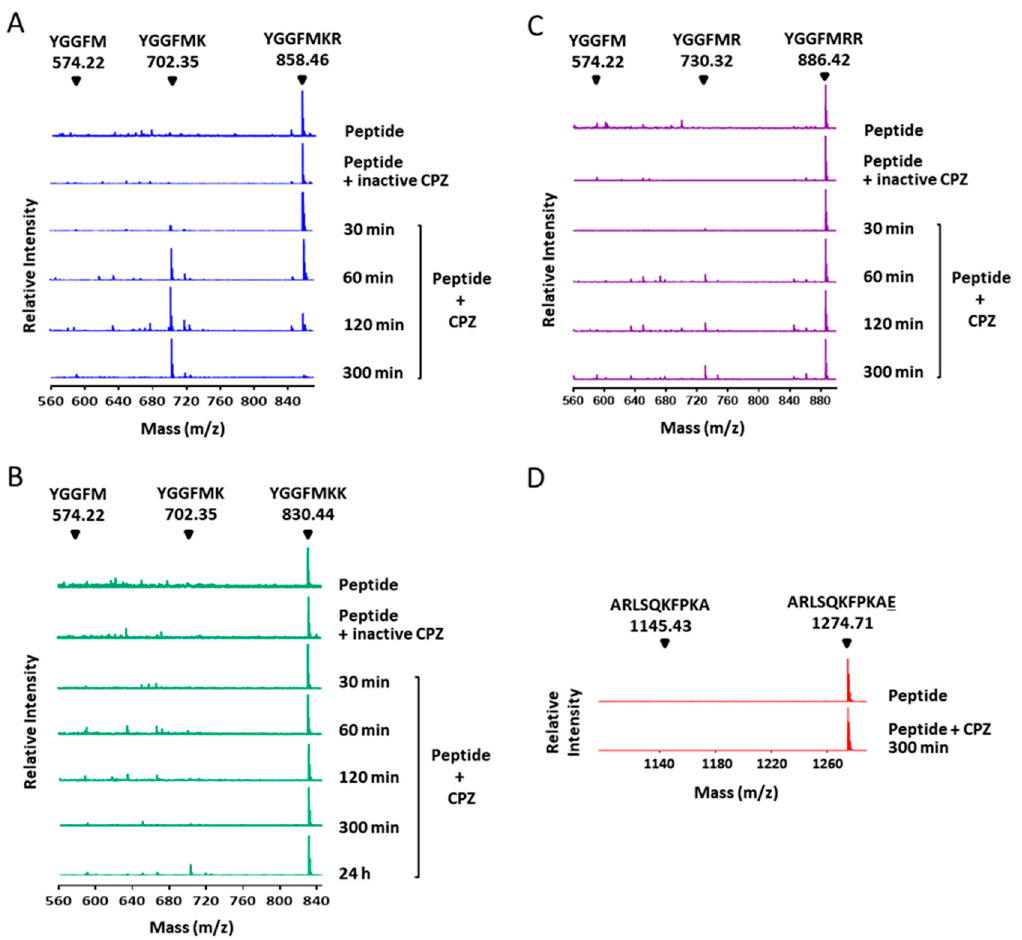
Figure 7. Substrate specificity of CPZ against Met-enkephalin-derived peptides. MALDI-TOF MS spectra of Met-enkephalin-derived peptides ( A ) YGGFMKR, ( B ) YGGFMKK, and ( C ) YGGFMRR treated with 100 nM CPZ at 37 °C with different incubation times. The peaks with a mass of 858.46 Da, 830.44 Da and 886.42 Da correspond to the peptides YGGFMKR (theoretical monoisotopic MH+ mass = 858.41 Da), YGGFMKK (theoretical monoisotopic MH+ mass = 830.41 Da) and YGGFMRR (theoretical monoisotopic MH+ mass = 886.42 Da) respectively. The peak with a mass of 702.35 Da generated in the presence of CPZ corresponds to the peptide YGGFMK (theoretical monoisotopic MH+ mass = 702.31 Da) produced by the cleavage of the C-terminal Arg or Lys amino acids from the peptides YGGFMKR and YGGFMKK, respectively. The peak with a mass of 730.32 Da generated in the presence of CPZ corresponds to the peptide YGGFMR (theoretical monoisotopic MH+ mass = 730.32 Da) produced by the cleavage of the C-terminal Arg from the peptide YGGFMRR. The position for the peptide YGGFM (with mass of 574.22 Da) is indicated. CPZ was inactivated by incubating the enzyme for 15 min at 90 °C to be used as a control reaction (peptide + inactive CPZ). Control samples were incubated for 24 h at 37 °C; ( D ) Spectra of the synthetic peptide ARLSQKFPKAE after 300 min of incubation in the absence (peptide) or in the presence of 100 nM CPZ (peptide + CPZ). Numbers above the major peaks indicate the monoisotopic masses of the MH+ ion (m/z) for the full-length peptide (mass = 1274.71 Da) or the peptide without its C-terminal residue, ARLSQKFPKA (mass = 1145.43 Da).